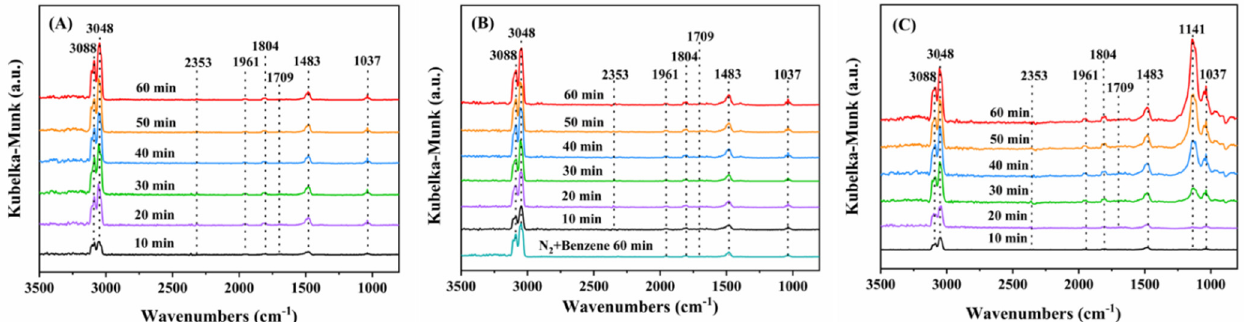
Figure 10. In situ DRIFTS spectra of the 0.94Pt-1.0rGO/ α -MnO 2 samples in the presence of ( A ) (1000 ppm benzene + N 2 (balance)), ( B ) (1000 ppm benzene + 20 vol% O 2 + N 2 (balance)), and ( C ) (1000 ppm benzene + 50 ppm SO 2 + 20 vol% O 2 + N 2 (balance)) after 10–60 min of reaction at 160 °C.